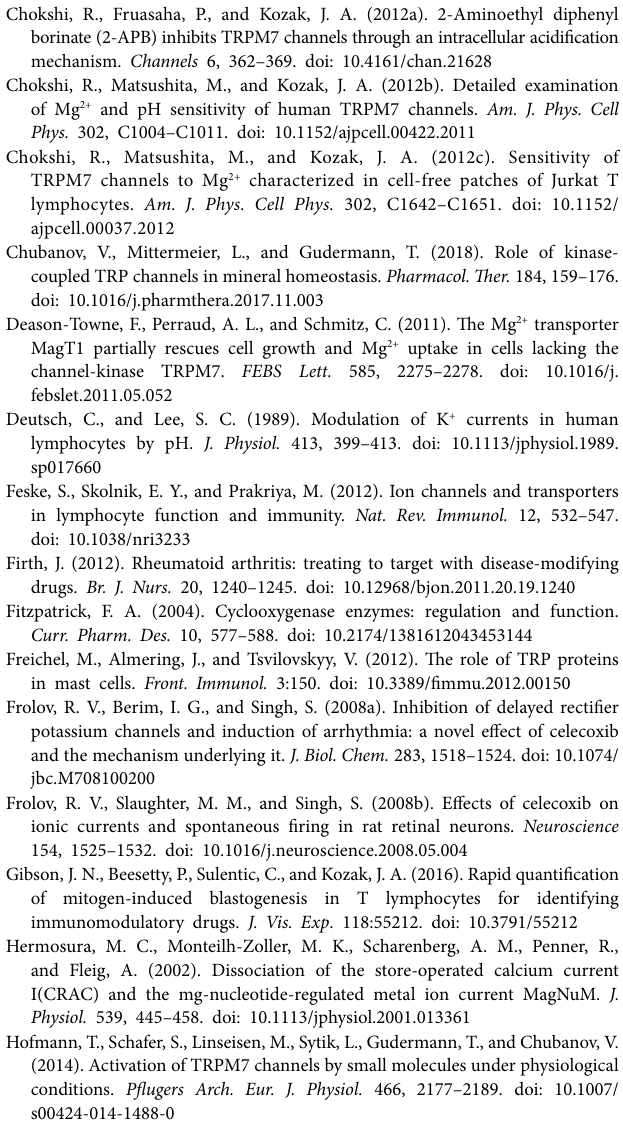
Supplementary Figure S1 | Effect of repeated application of ibuprofen on the degree of acidification. Effects of naproxen and salicylate on cell viability. (A) 10 mM ibuprofen-Na + was applied to BCECF-loaded Jurkat T cells three times sequentially followed by washes. There was no change in the extent of acidification (F 490 nm / 440 nm) during repeated application of the drug. (B) Jurkat T-cell viability was measured after a 24-hour incubation in the absence (control) or presence of 0.3, 3 and 10 mM naproxen-Na + . Each bar represents the percentage of cells (mean, SEM) which excluded trypan blue dye. (C) Mean Jurkat T-cell viability after a 24-hour incubation in the absence and presence of 0.3, 3 and 10 mM salicylate. Asterisks in (B)